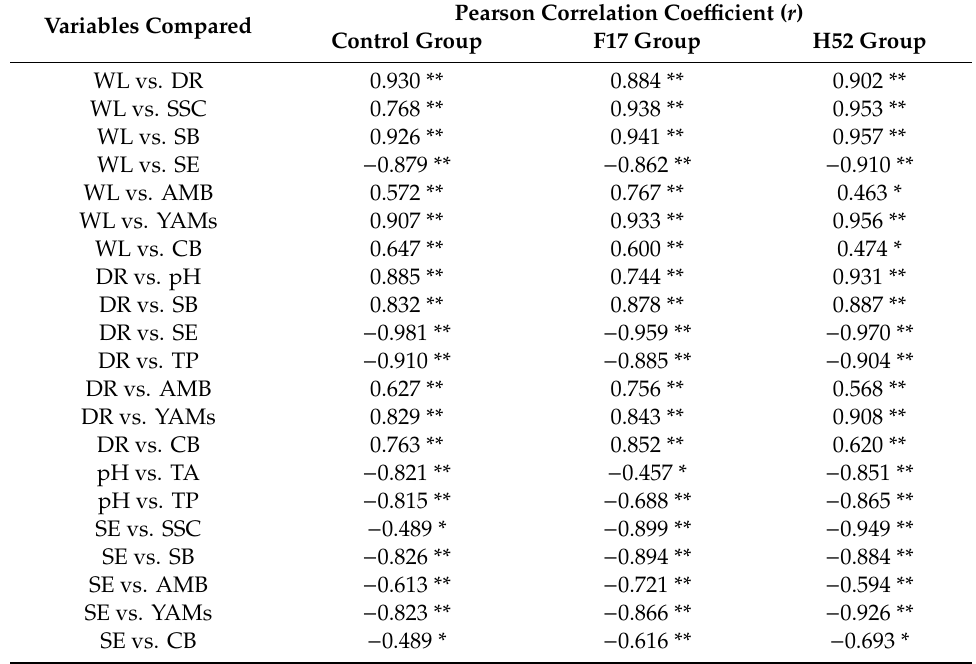
Table 3. Correlation between some selected quality parameters of table grapes treated and untreated with strains F17 or H52 supernatants during 20 d of 25 ◦ C